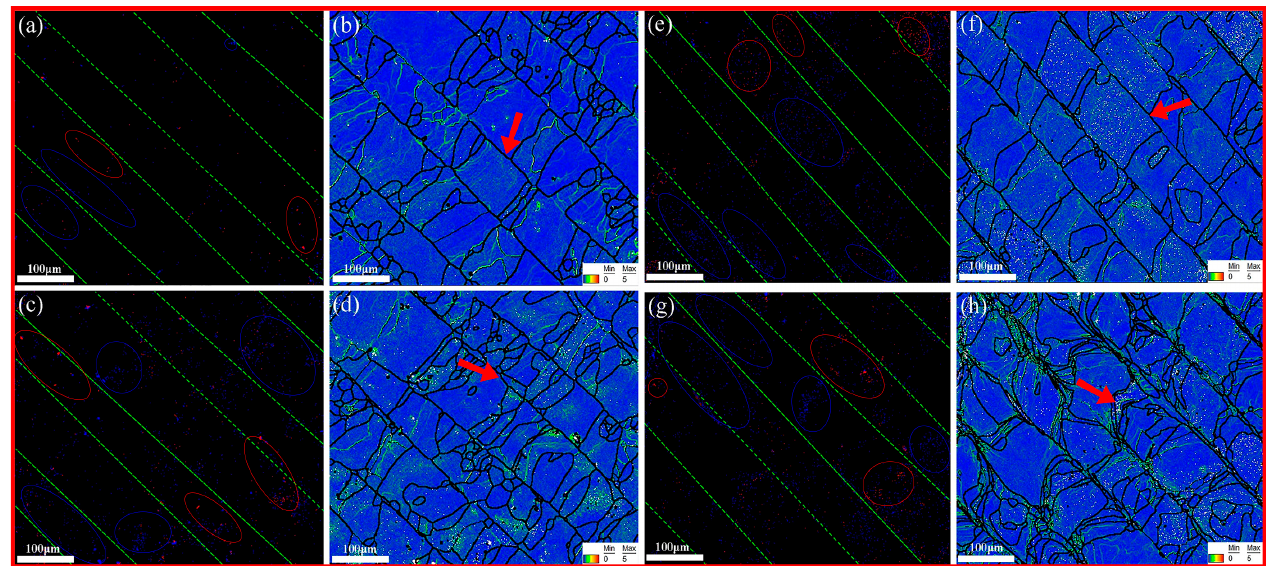
Figure 10. Phase maps of the SLM-fabricated Ti-22Al-25Nb samples: ( a , b ) sample 1, ( c , d ) sample 2, ( e , f ) sample 3, and ( g , h ) sample 4.